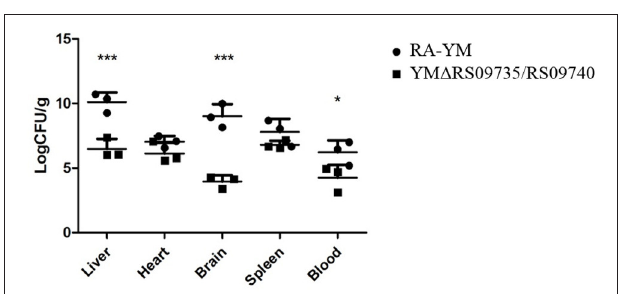
FIGURE 3 | Bacterial loadings in R. anatipestifer YM and YM 1 RS09735/RS09740 in infected duckling tissues. Twelve 12-day-old ducks infected with the wild-type R. anatipestifer strain or mutant strain YM 1 RS09735/RS09740. Blood, heart, liver, brain, and spleen samples were collected at 48 h after injected flippers. * P < 0.05, *** P < 0.001.